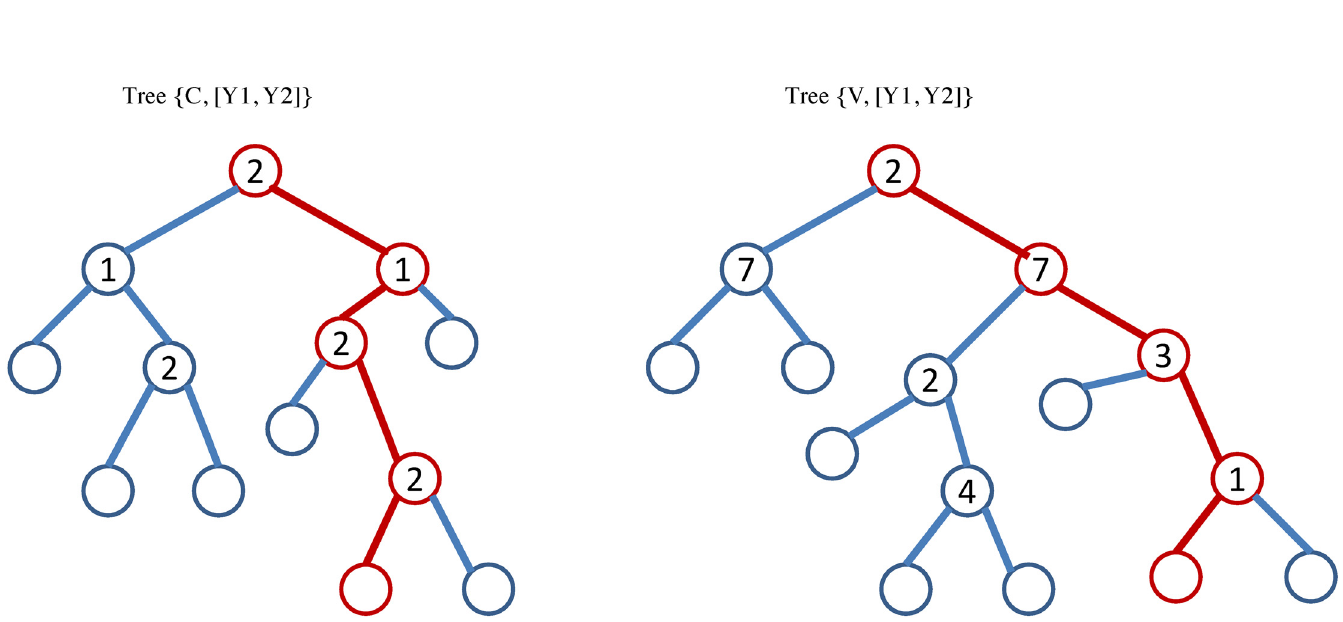
Fig 4. Two multivariate regression trees trained on the same input X and same output responses [Y 1 ,Y 2 ] but the node cost criteria being copula based ( Tree {C, [Y 1 ,Y 2 ]}) and covariance based ( Tree {V, [Y 1 ,Y 2 ]}) respectively. The empty circles represent leaf nodes and the circles enclosing a number signifies a split node; the number inside the circle indicates the featured selected on that node for splitting.